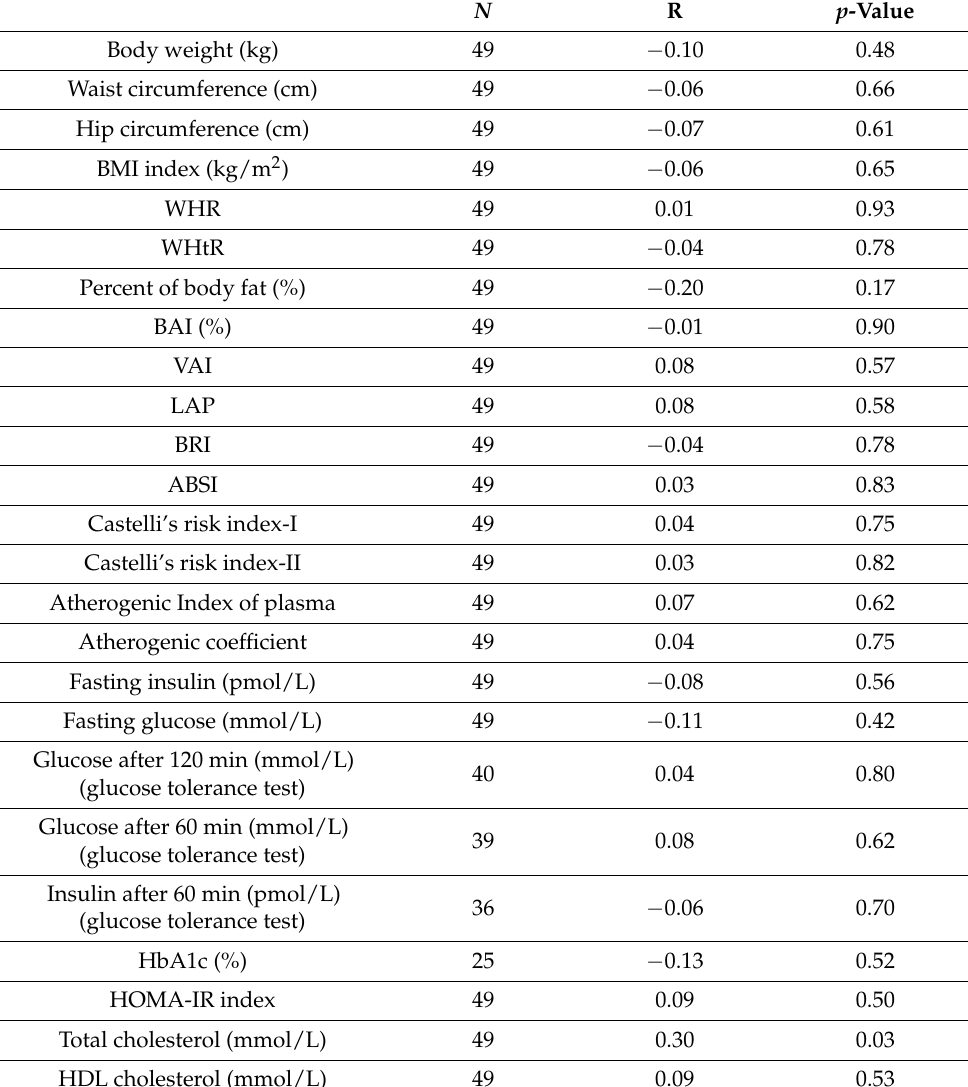
Table 5. Correlation between fetuin-A and selected anthropometric and biochemical